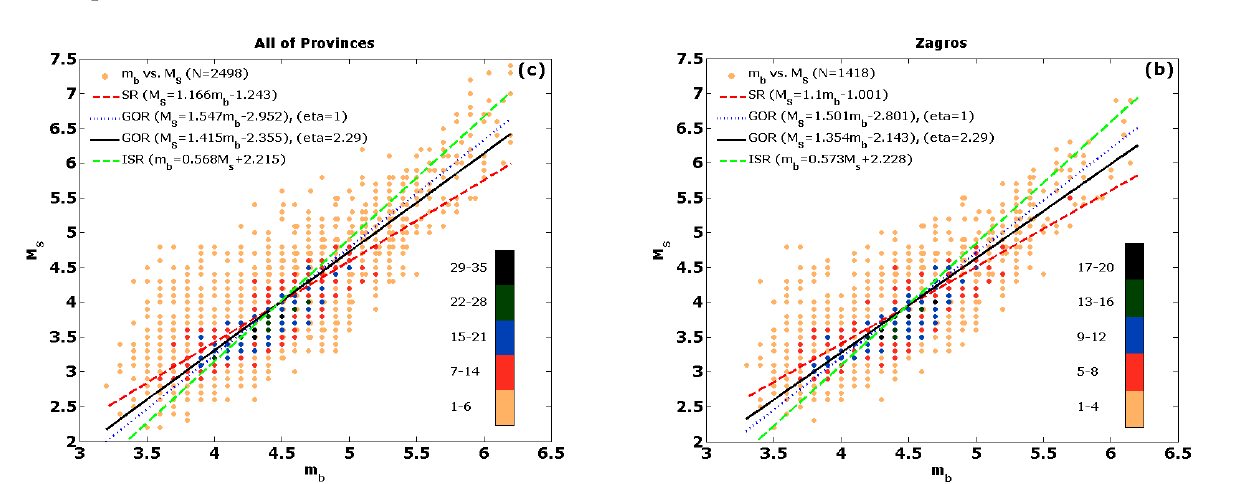
–M conversion relations for major seismotectonic provinces in Iran. Abbreviations as Figure b s